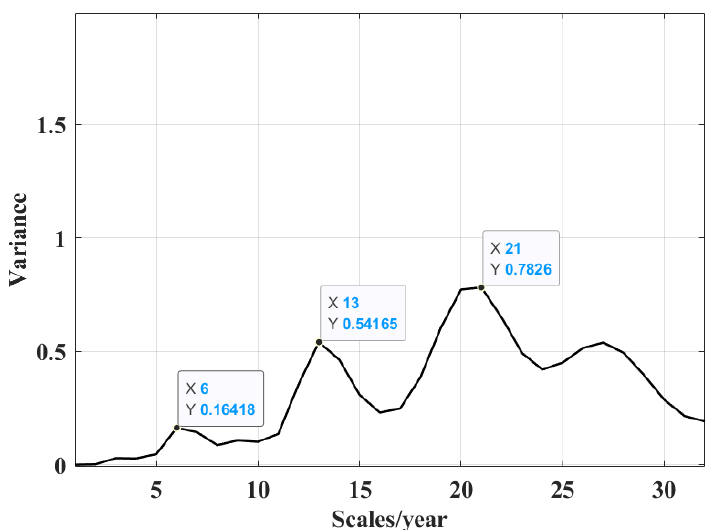
Figure 6. Variance diagram of wavelet analysis of annual evaporation at Station 56093 in the Yangtze River